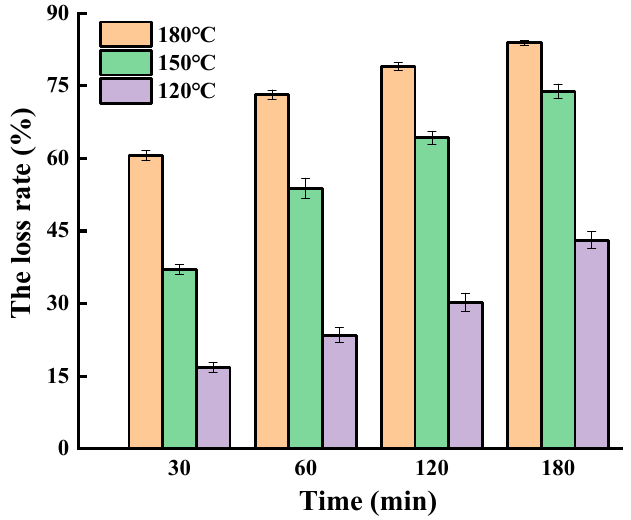
Figure 1. The loss rate of soybean germ phytosterols in the non ‐ oil system.